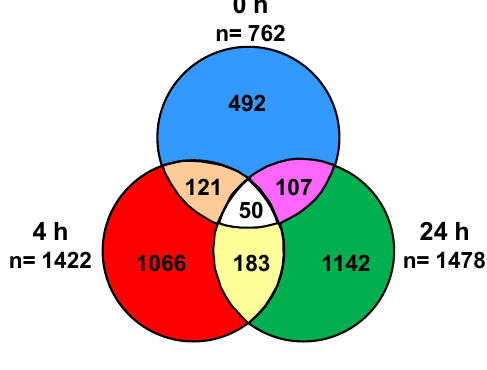
Figure 5. Identification of unique and shared genes. The Venn diagram indicates the number of unique and common differentially expressed genes at each time point. Biomarker comparison analysis was performed in